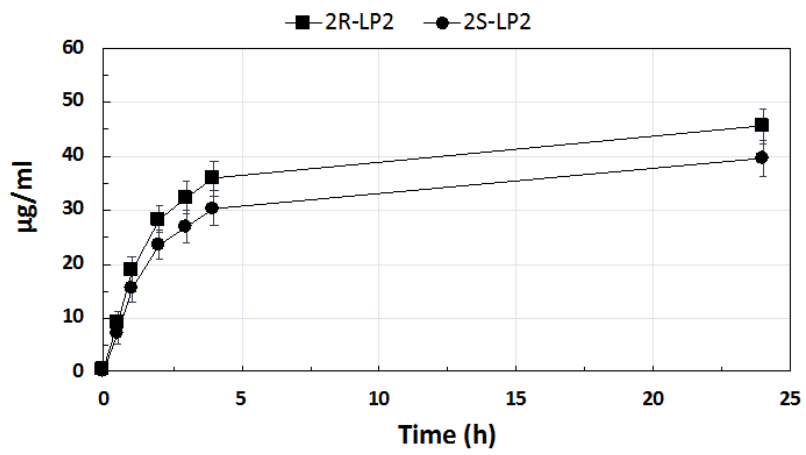
Figure 4. In vitro release from solid lipid nanoparticles of 2 R ‐ LP2 and 2 S ‐ LP2.